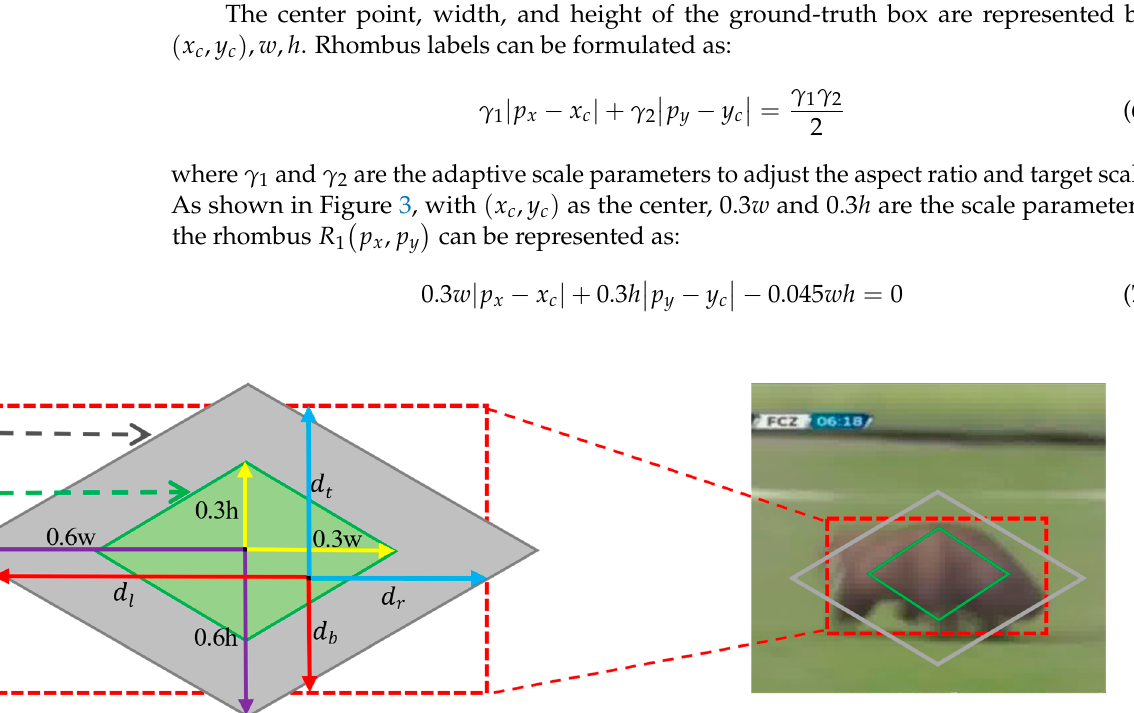
Figure 3. The rhombus classification labels and four sides regression of bounding